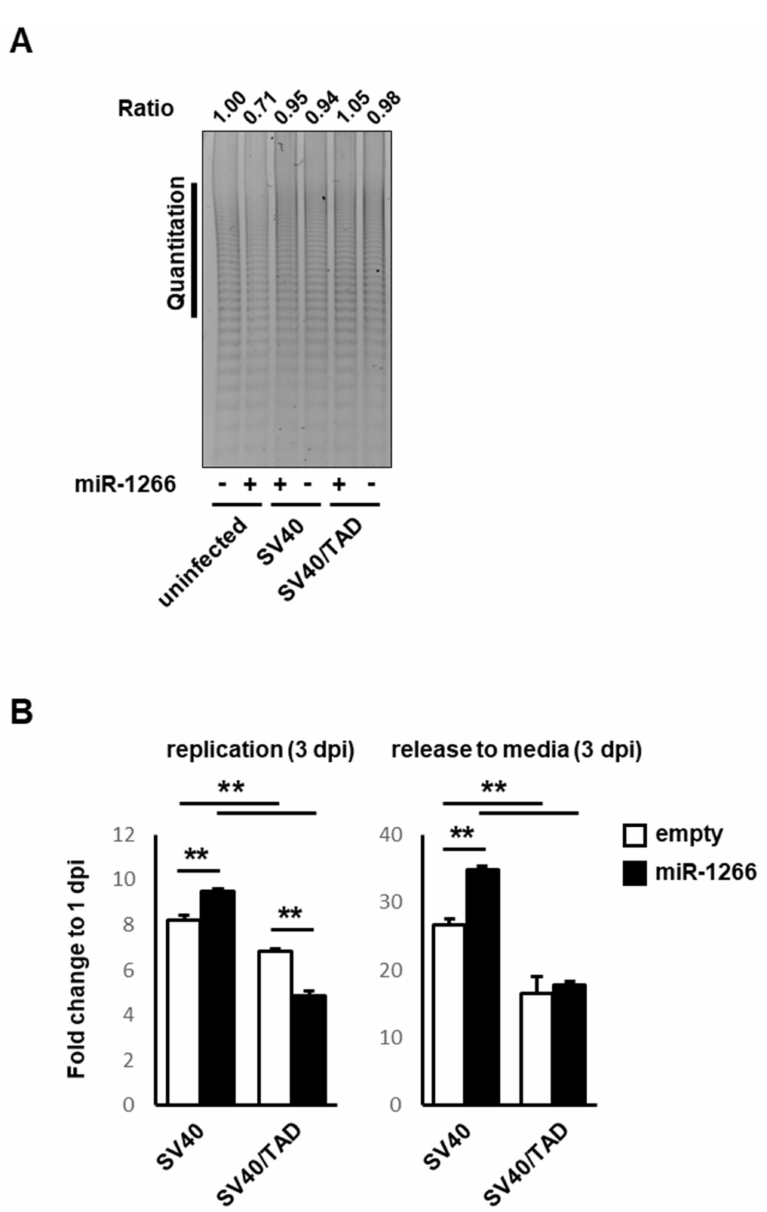
Figure 6. The interplay between miR-S1 and miR-1266 promotes TERT activity and viral replication of SV40. ( A ) Using the TRAP assay, cellular TERT activities in uninfected, SV40, or SV40/TAD-infected control and miR-1266 − expressing A549 cells were determined. TRAP reactions were conducted by 80 cells per reaction. Using ImageJ software, specific activities were calculated by quantifying the intensity of ladder bands at vertical lines (middle − long telomeric repeats). All experiments were repeated two times. ( B ) Control and miR-S1 − expressing A549 were infected with SV40 or SV40/TAD, and then genomic DNA from cells or culture media was subjected to RT-qPCR with the specific primers for LSTag. Fold changes of the SV40 level at 3 dpi were determined by dividing them by 1 at 1 dpi. All experiments were repeated two times. Columns, mean values ( n = 3); bars, SD; ** p <